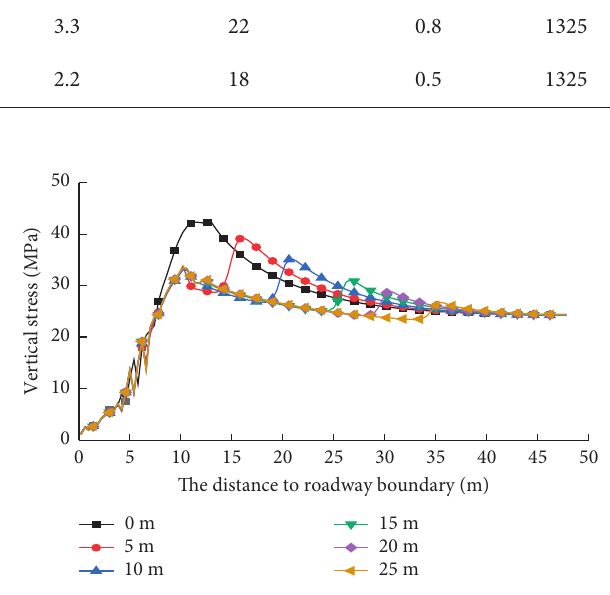
Figure 12: Vertical stress redistribution after hydraulic fracturing in different water injection section